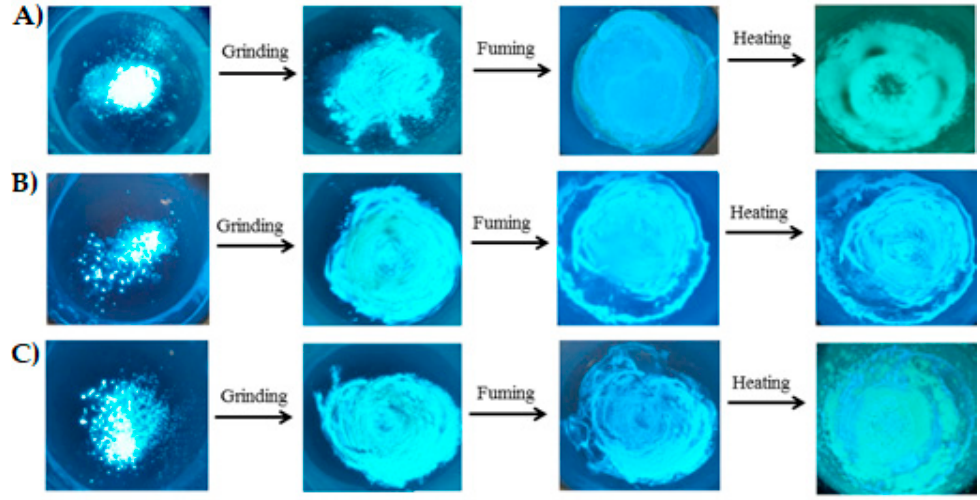
Figure 5. The mechanochromic properties of ( A ) TPE-Pi , ( B ) TPE-Su , and ( D ) TPE-Az , showing the luminescence changing of these compounds after grinding, fuming and heating.